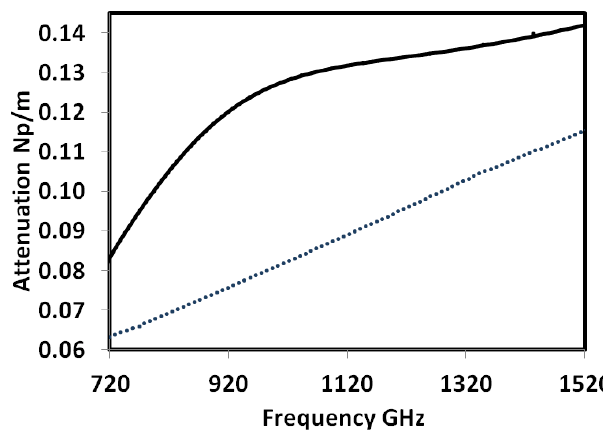
Figure 6: Attenuation of TE11 mode above the gap frequency in a Nb circular waveguide (with 8.1 mm radius), operating at 4.2 K (solid line) and room temperature (dotted